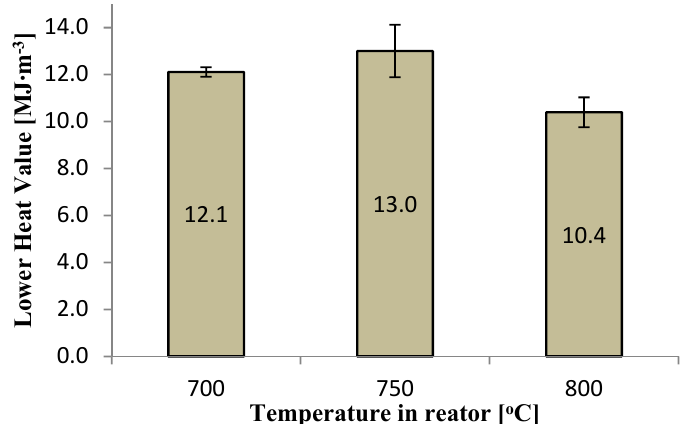
Figure 5. Impact of the temperature in the reactor on the syngas lower heat value.